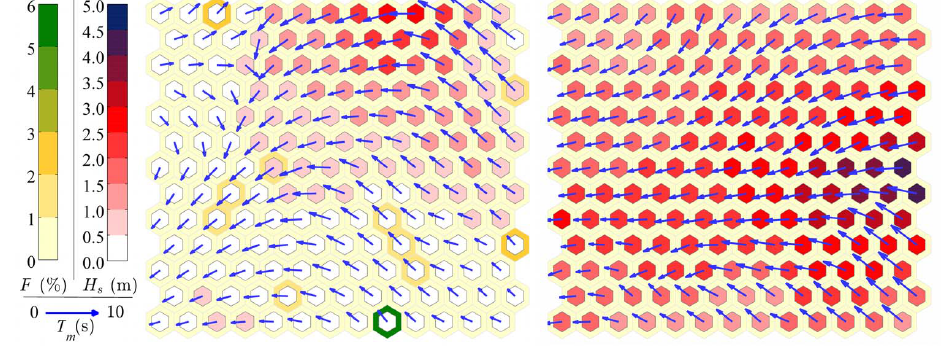
Figure 13. POT-SOM output map. H s : inner hexagons’ color, T m : vectors’ length, θ m : vectors’ direction, F : outer hexagons’ color. Wave climate after single-step SOM (left panel) and stormy wave climate (right panel). For the right panel map, mean quantization error: 0.06; topographic error: 12%. Table 3. Performance summary of different SOM approaches, through the comparisons of reconstructed to original time series, and